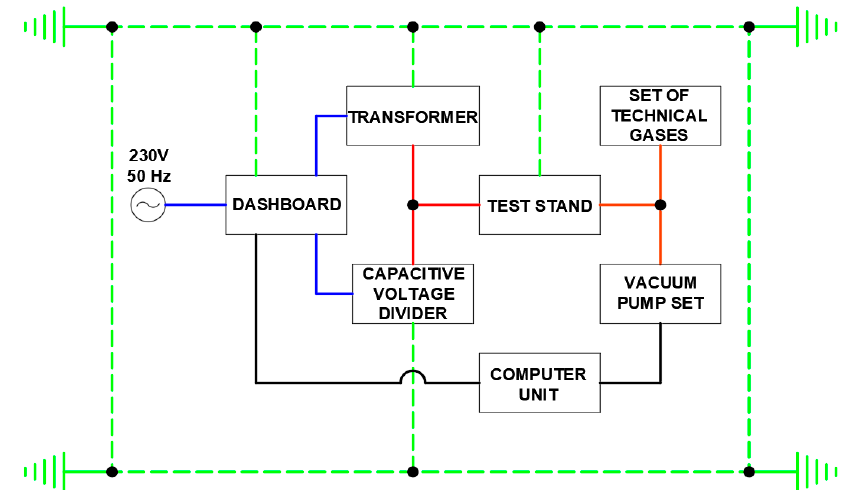
Figure 5. Block diagram of a laboratory station designed to test electrical strength of a vacuum insulation system (blue lines—low-voltage part, red lines—high-voltage part, orange lines—vacuum part, black lines—communication part, green lines—working ground of the station).